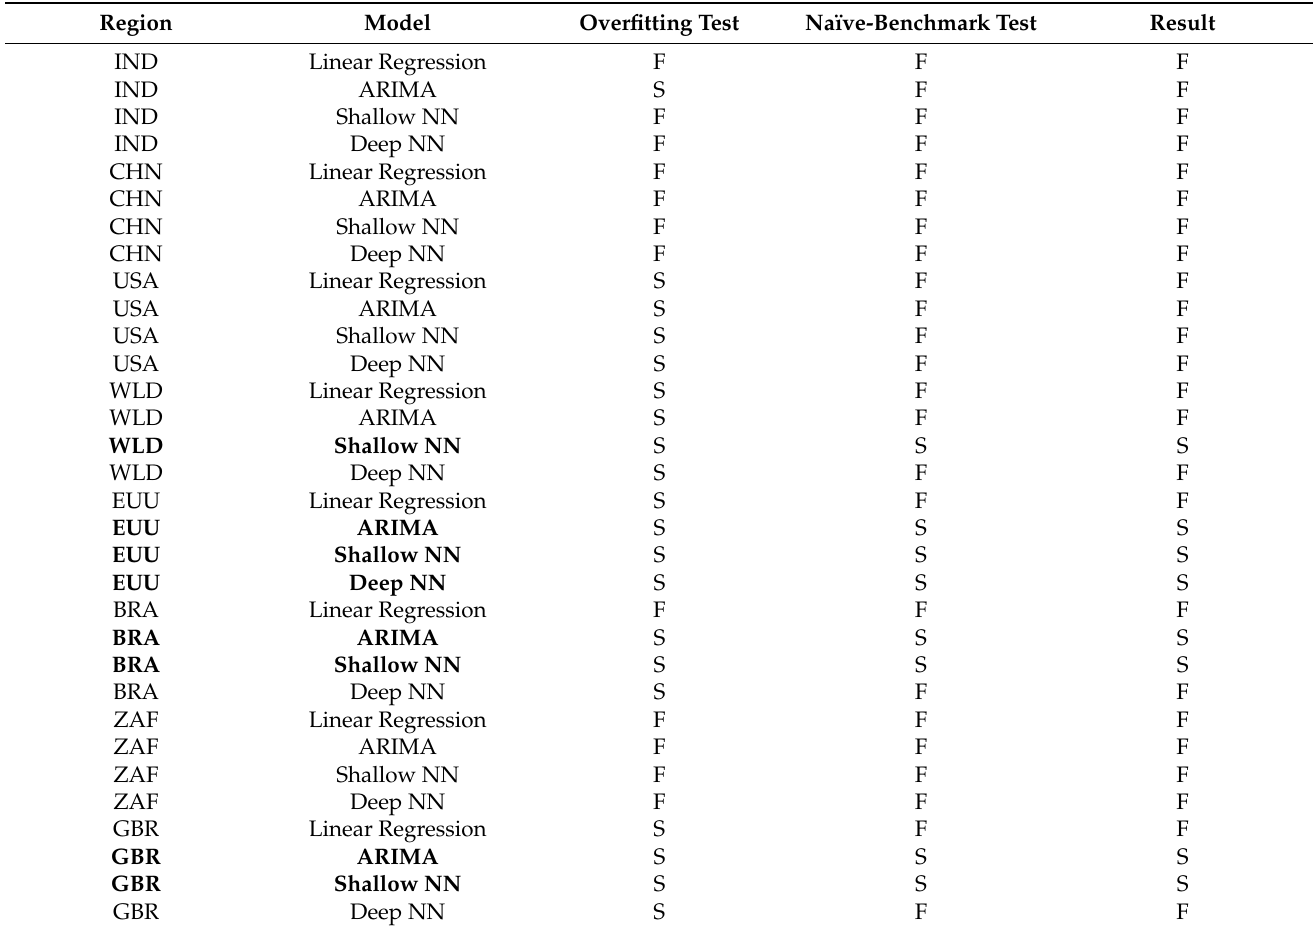
Table 16. Performance of models per test. F and S stand for failed and succeeded, respectively. The models that pass both tests are in